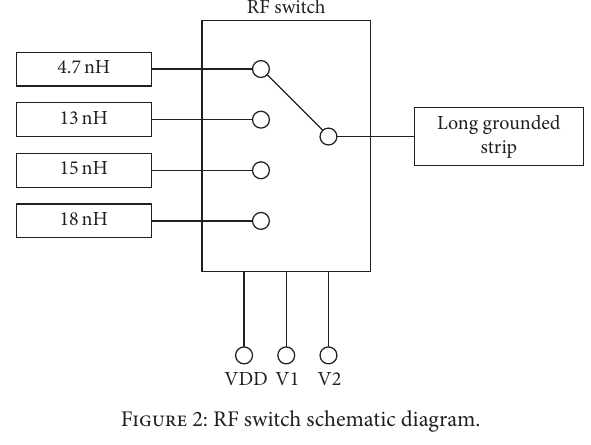
Figure 2: RF switch schematic diagram.